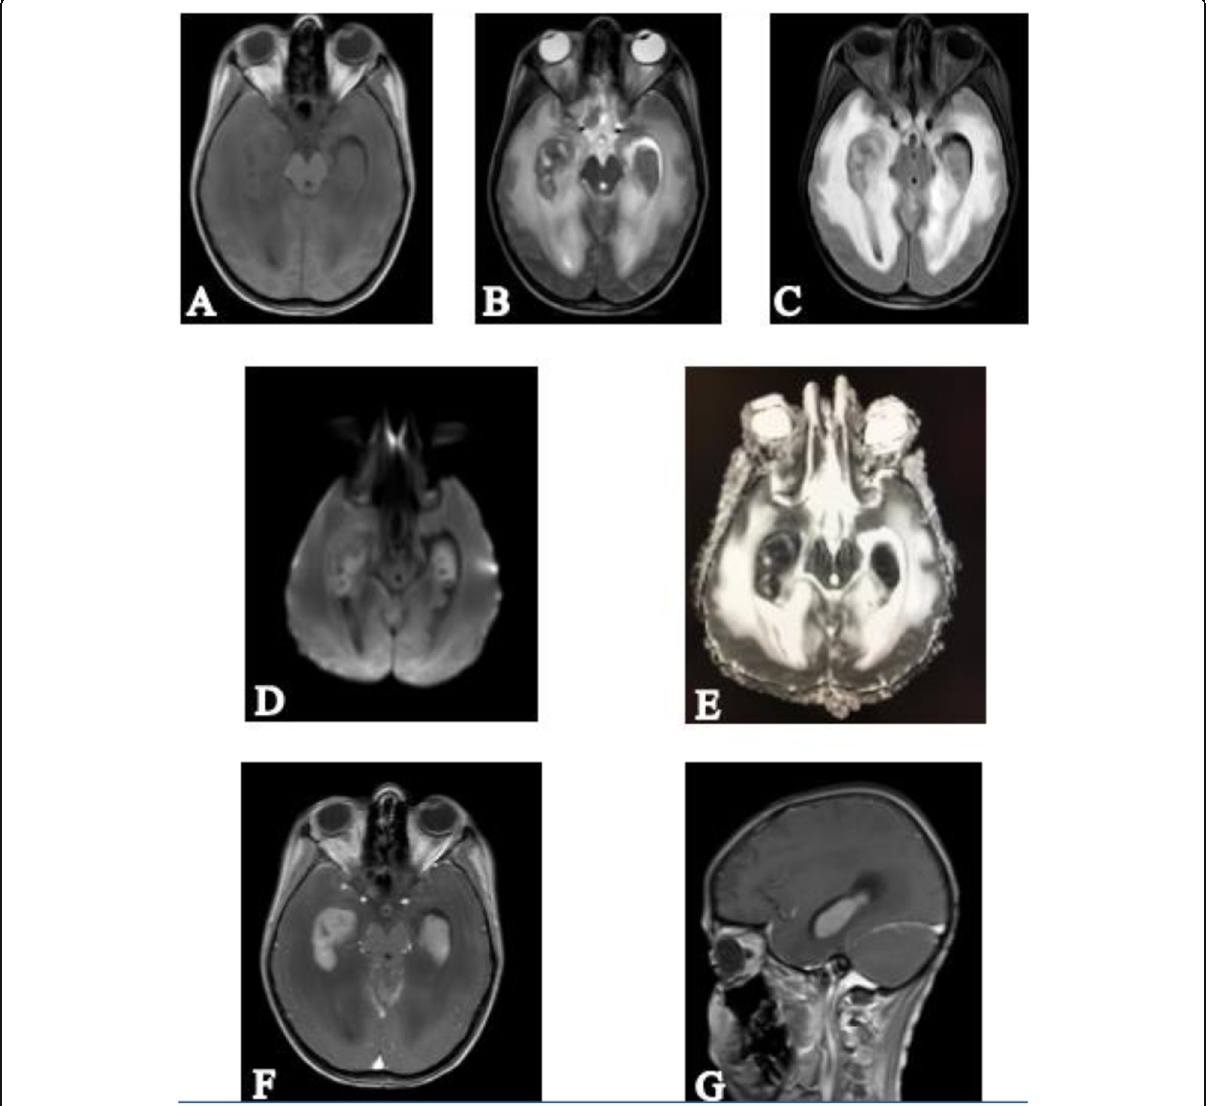
Fig. 9 Leptomeningeal infiltration. Male patient, 15 years old, diagnosed with ALL ended treatment. Axial MRI images of the brain at the level of tempro-occipital region: a axial non-contrast T1WI, b axial T2WI, and c axial FLAIR images show bilateral intra ventricular masses seen filling the temporal horns of both lateral ventricles intermediate signal in T1WI and faint bright signal in T2WI and FLAIR images. Significant periventricular edema is seen eliciting high FLAIR signal. Axial DWI ( d ) and ADC image ( e ) show diffusion restriction of intra-ventricular masses. f , g Images axial ( f ) and sagittal ( g ) post-contrast-enhanced MRI of the brain show avid enhancement of the intra-ventricular masses